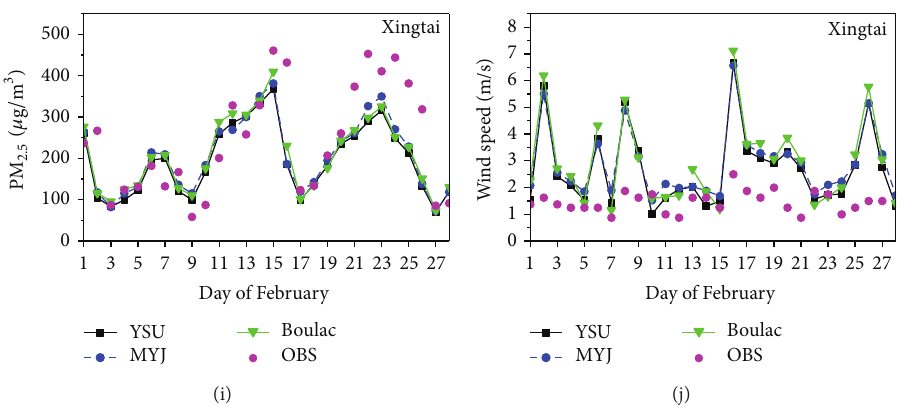
Figure 5: Variations of the daily averaged PM 2.5 concentration ((a), (c), (e), (g), and (i)) and wind speed near-surface ((b), (d), (f), (h), and (j)) at 5 sites of different terrain in